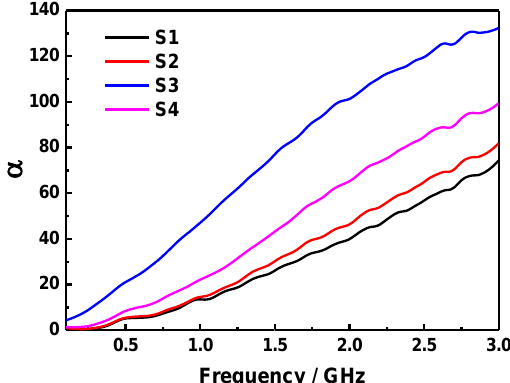
Figure 10. Attenuation constants of S1, S2, S3, and S4 at the thickness of 4 mm.